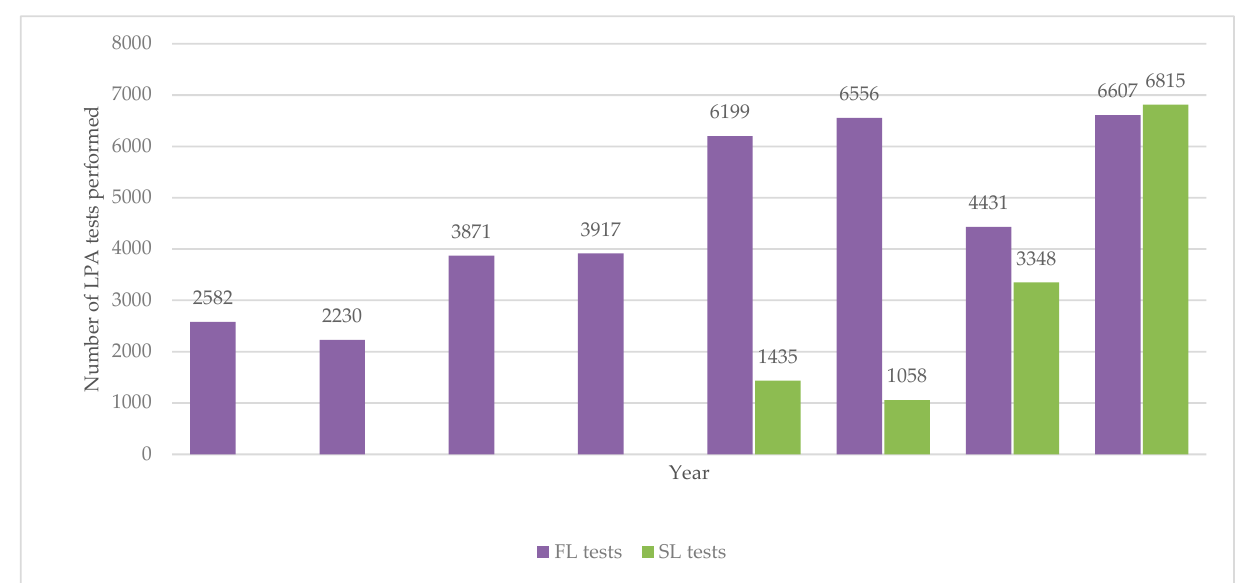
Figure 4 : Number of LPA tests (first- and second-line) performed each year in Uzbekistan from 2012 to 2019. LPA = line probe assay; FL = first-line; SL = second-line.